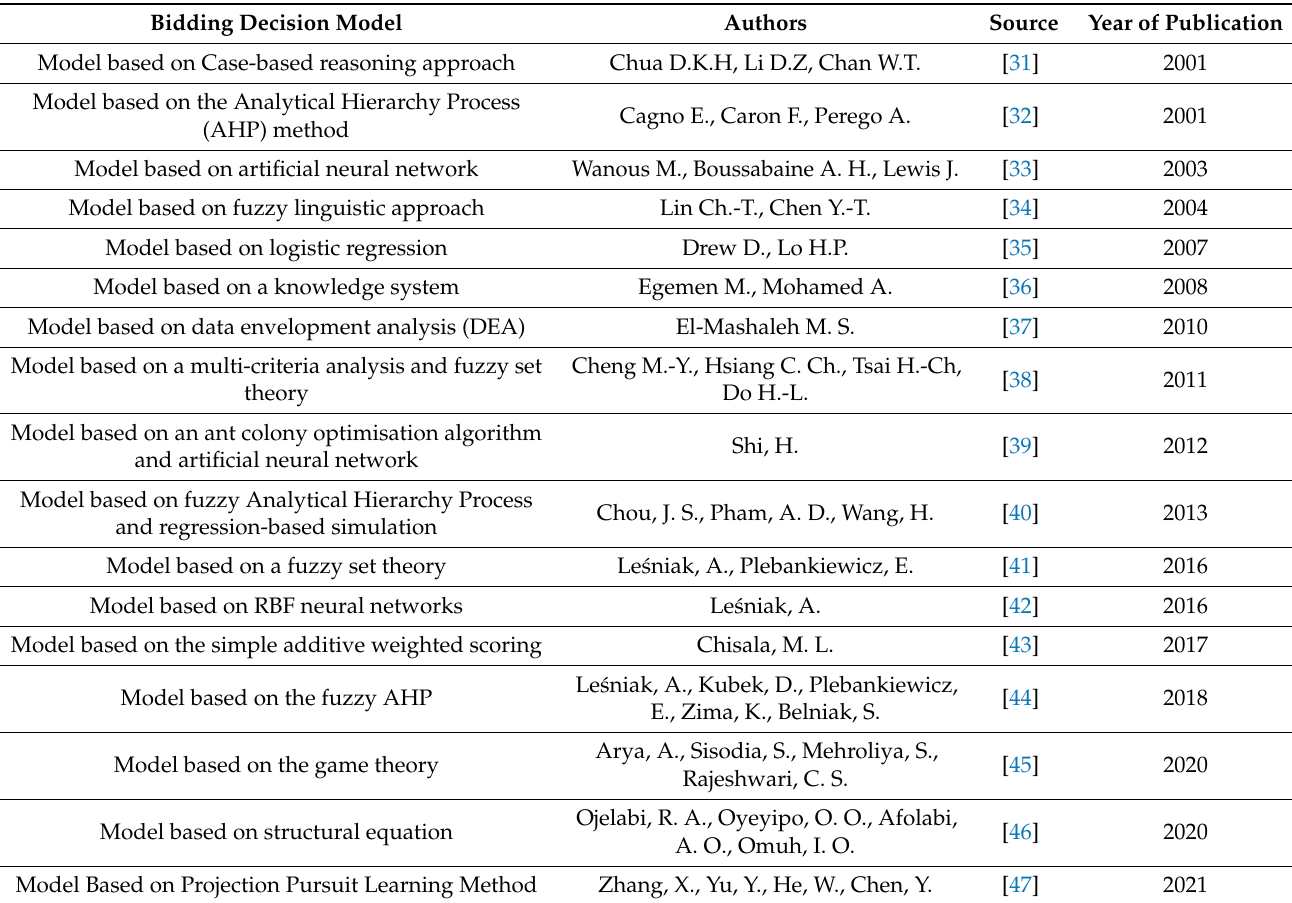
Table 1. Examples of models supporting tender decisions presented in the literature after